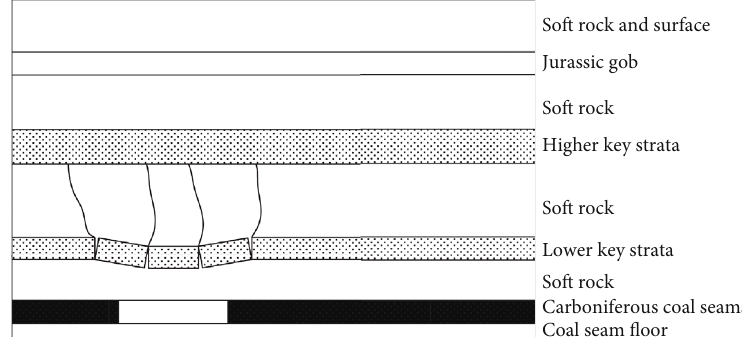
Figure 8: Distribution diagram of gas-conducting fracture fi eld before fracture of the higher key strata.